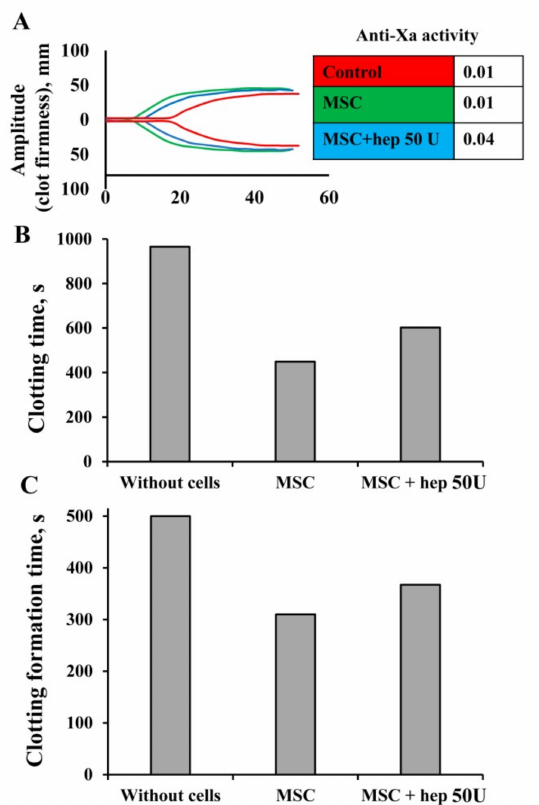
Figure 8. Modulation of MSC procoagulant activity by heparin pretreatment in vitro. ( A ) Representative diagram of thromboelastometry. ( B ) Clotting time and ( C ) clot formation time assayed by the NATEM test. MSCs were pretreated with 50 U heparin for 10 min, followed by washing three times in PBS. Further, MSCs were added to 1 mL of freshly obtained blood, reaching a final concentration of 5 × 10 4 cells per mL, then 300 µ L of the suspension was sampled for